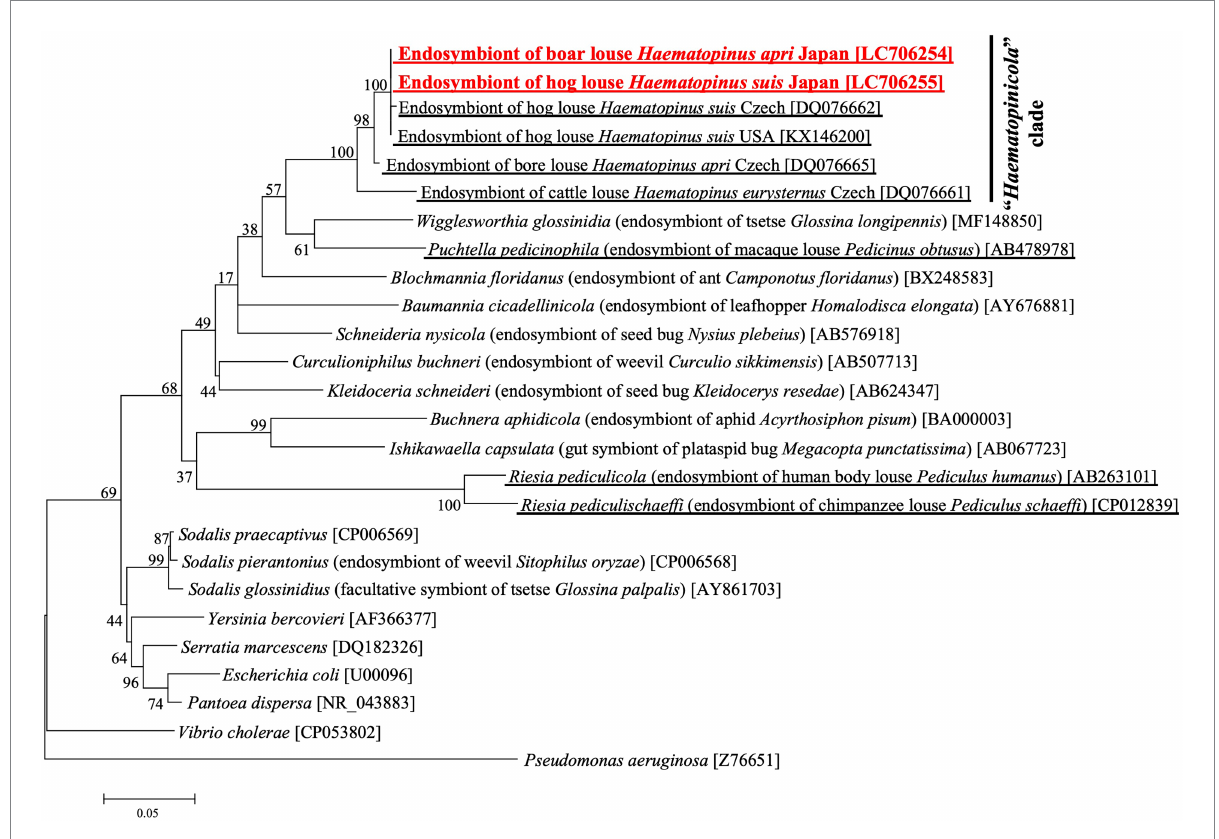
FIGURE 2 Phylogenetic placement of the primary endosymbionts of the boar louse H. apri and the hog louse H. suis based on 16S rRNA gene sequences. A maximum-likelihood phylogeny inferred from 1,013 aligned nucleotide sites is shown with bootstrap probability at each node (model: K2 + G + I). Host insect information is shown in parentheses, whereas accession number is indicated in brackets. The louse endosymbiont sequences determined in this study are highlighted in red, whereas the louse endosymbiont sequences reported in previous studies are